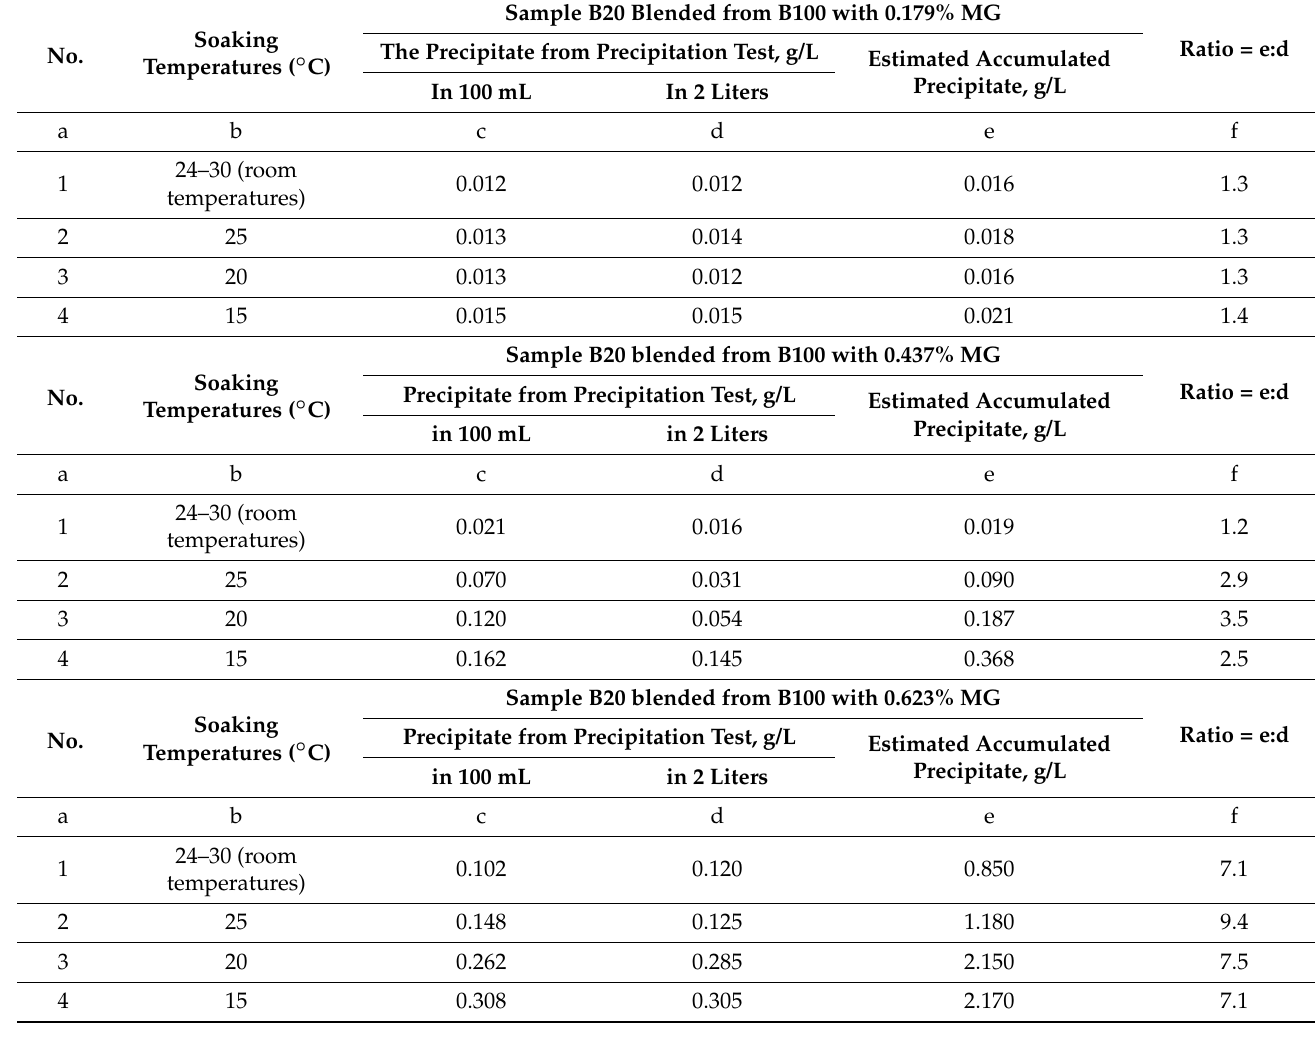
Table 4. Accumulated precipitate from precipitation tests for B20 fuel blended from B100 with